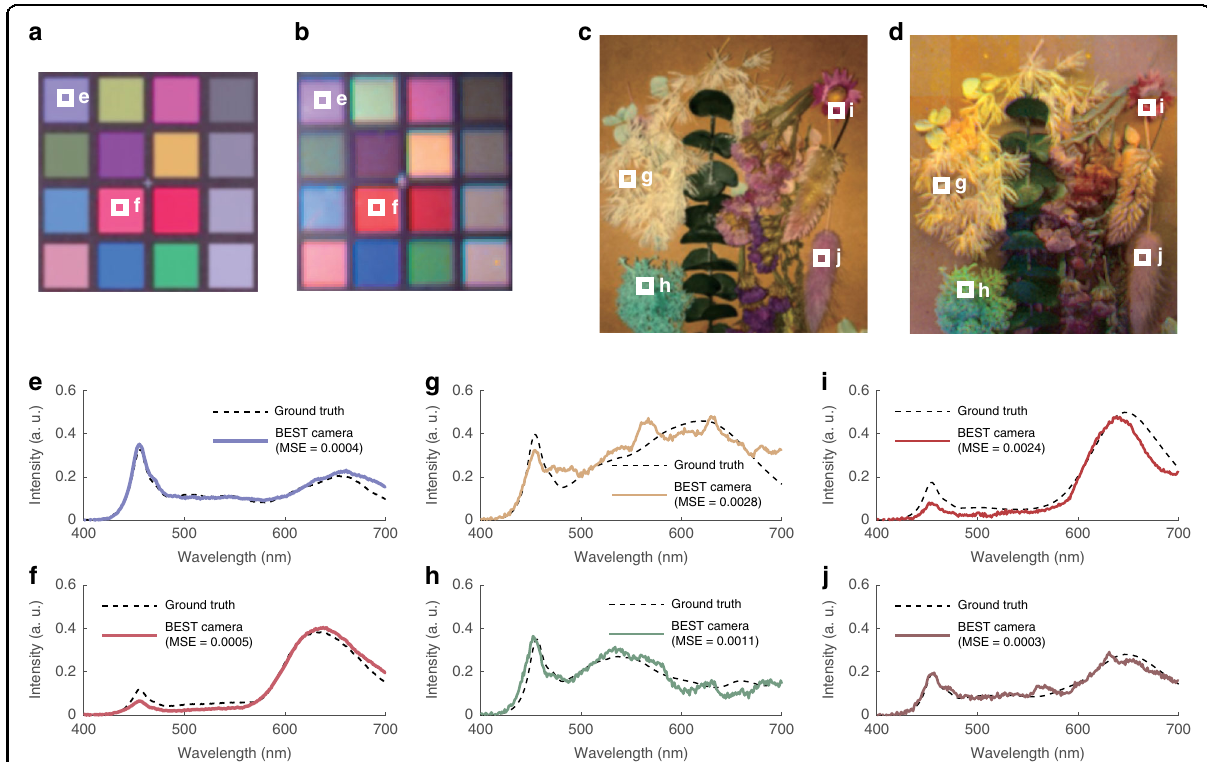
Fig. 2 Applications of BEST camera in passive mode. a Photo of the color patches from the standard color calibration board. An RGB camera was used to take the photo. b Reconstructed spectral image (visualized in RGB form) of the color calibration card. Photo ( c ) and reconstructed spectral image ( d ) of practical plant sample. e – j Spectral pro fi les at the positions denoted by the white squares in a – d . The ground truths (measured by a commercial spectroradiometer, Konica Minolta CS-2000) and the DNN reconstructed results are represented by solid (reconstructed) and dashed (ground truth) curves,